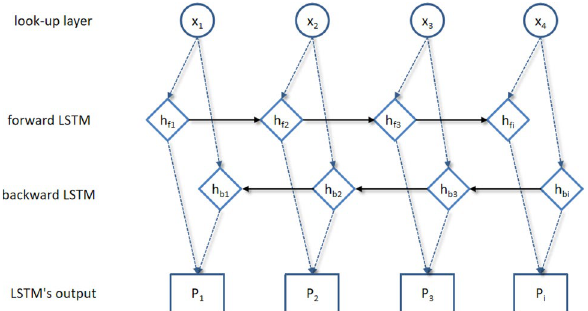
Figure 3. BiLSTM model structure